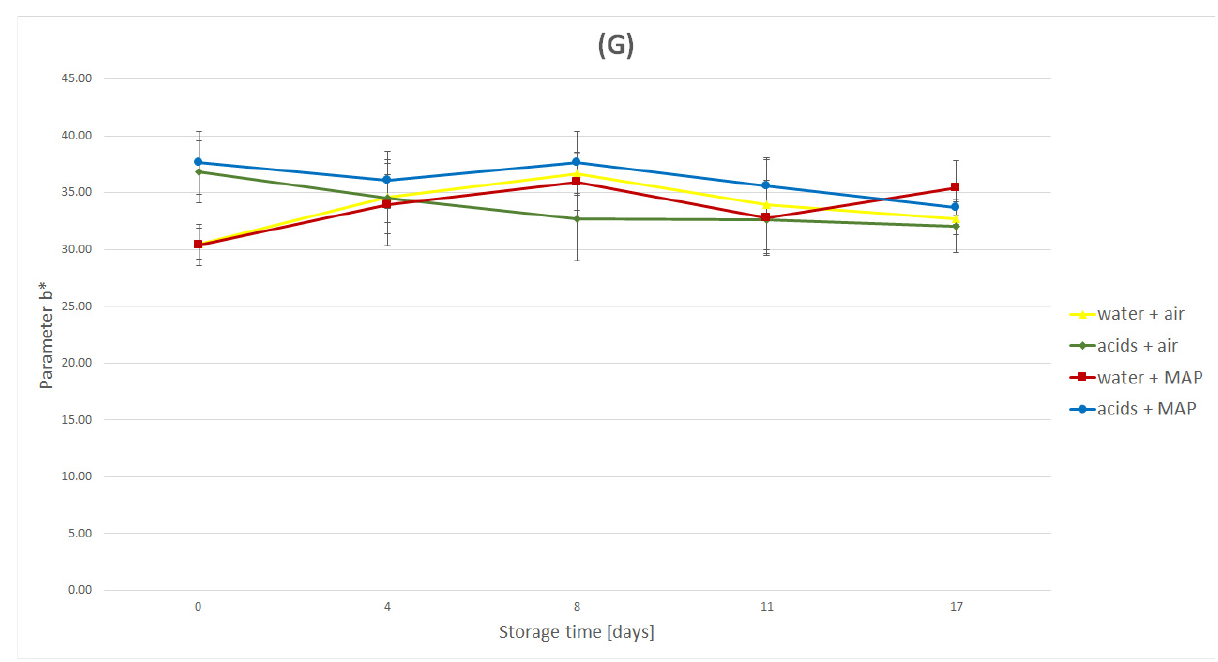
Figure 1. Changes in the concentration of oxygen ( A ), carbon dioxide ( B ), pH ( C ), firmness ( D ), and color ( E – G ) of carrots under various packaging and storage conditions.